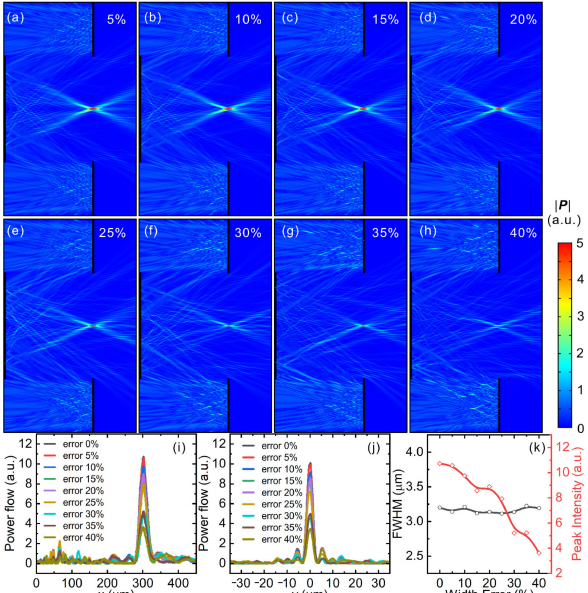
Figure 5. Energy flux of a metasurface Cassegrain telescope with f-ratio of 5/12 with ( a ) 5%, ( b ) 10%, Also shown are line-cut plots of the energy flux at the focus along ( i ) x- and ( j ) y-directions, as well as ( k ) FWHM (black-curve) and peak intensity (red-curve) of the focus for different devices with various levels of random width error of